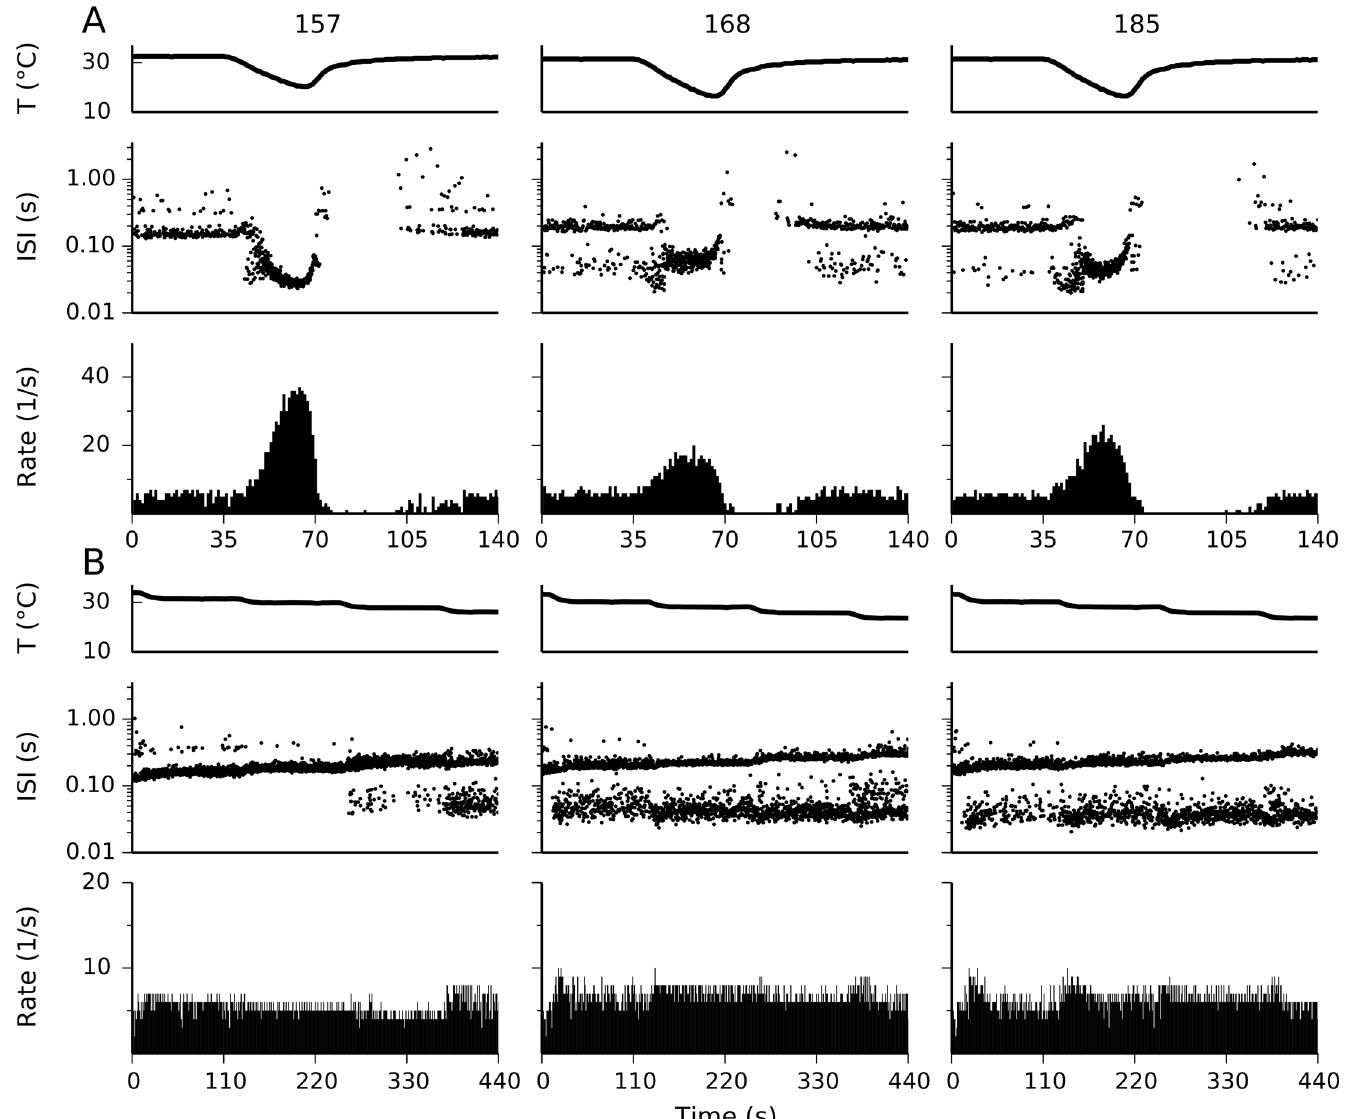
Fig 4. Dynamic and static response of three different set of parameters. Responses to an acute cold pulse (A) and to cooling steps (B) with three different sets of parameters (indicated at the top). Parameters are listed in Table 1. In B, the temperature steps are 31.5°C, 30.0°C, 28.0°C and